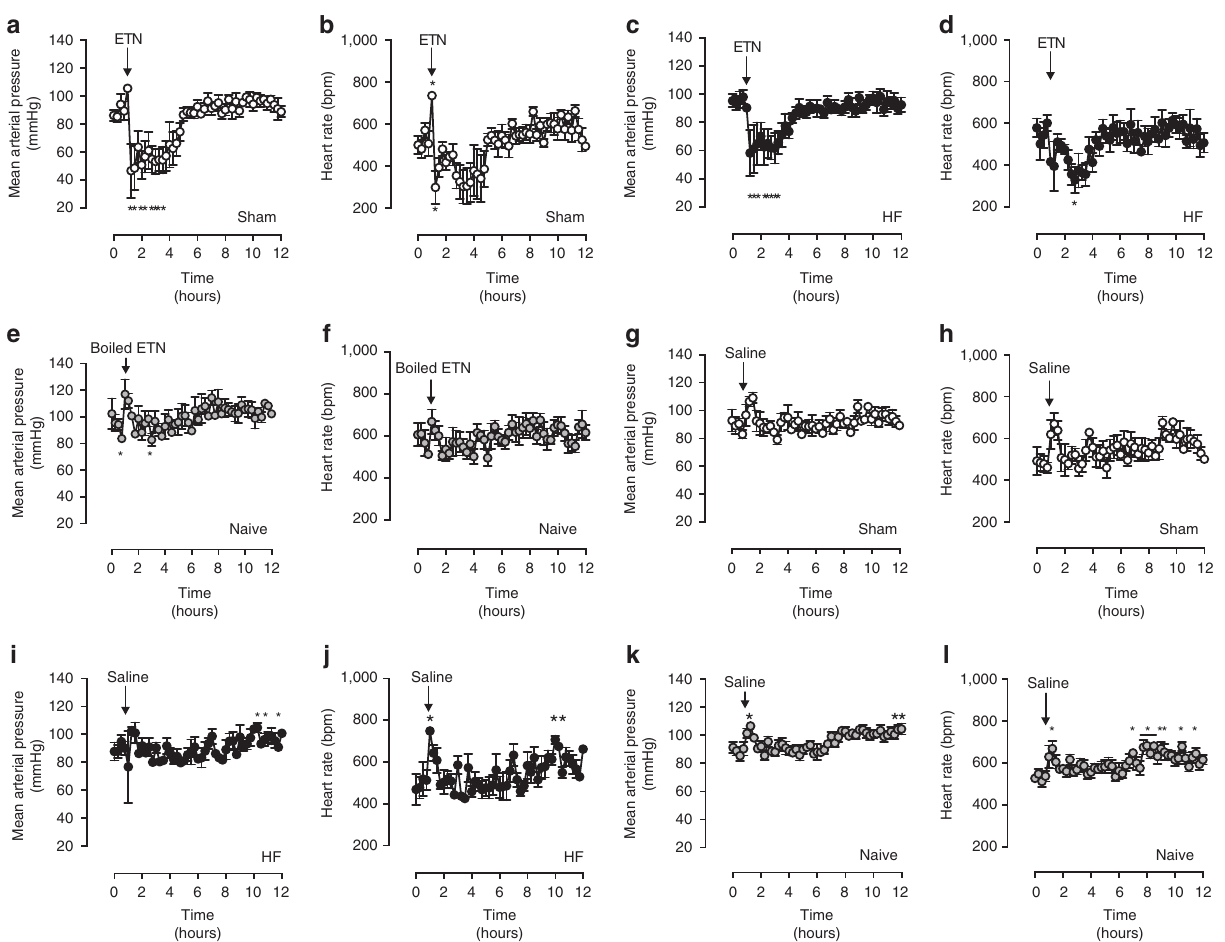
Figure 3 | Effects of acute TNF scavenging on systemic haemodynamics. Radiotelemetric haemodynamic measurements of sham-operated mice. ( a ) MAP and ( b ) heart rate in sham-operated mice injected with etanercept (ETN, 20mgkg (cid:2) 1 i.p., arrow, n ¼ 4 sham mice). ( c ) MAP and ( d ) heart rate measurements of mice with HF induced by left anterior descending coronary artery ligation and injected with ETN (20mgkg (cid:2) 1 i.p., arrow, n ¼ 4 mice). ( e ) MAP and ( f ) heart rate measurements of naive (non-operated) wild-type mice injected with boiled etanercept (boiled ETN, 20mgkg (cid:2) 1 i.p., arrow, n ¼ 4 mice). ( g ) MAP and ( h ) heart rate of sham-operated mice injected with saline (100ul, arrow, n ¼ 4 mice). ( i ) MAP and ( j ) heart rate of HF mice injected with saline (100ul, arrow, n ¼ 4 mice). ( k ) MAP and ( l ) heart rate of naive (non-operated) wild-type mice injected with saline (100ul, arrow, n ¼ 8 mice). All data are mean ± s.e.m. * P o 0.05 for one-way repeated-measures ANOVA and Dunnett’s post hoc test relative to 0h. ANOVA, analysis of